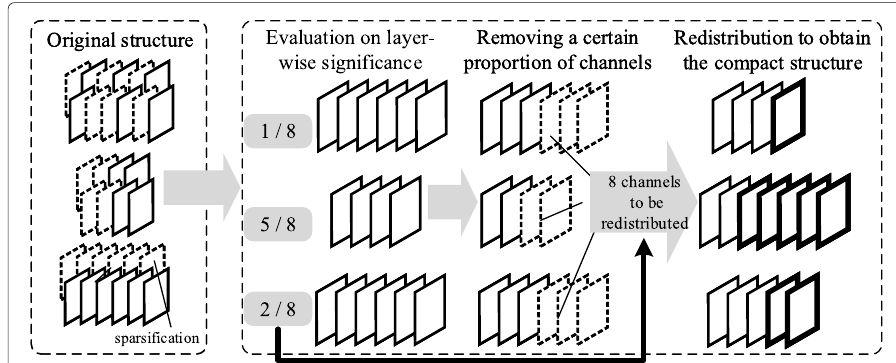
Fig. 3 An overview of channel-redistribution. The basic procedure includes evaluating the layer-level saliency, temporarily removing a certain proportion of channels and redistribution. Note that a process